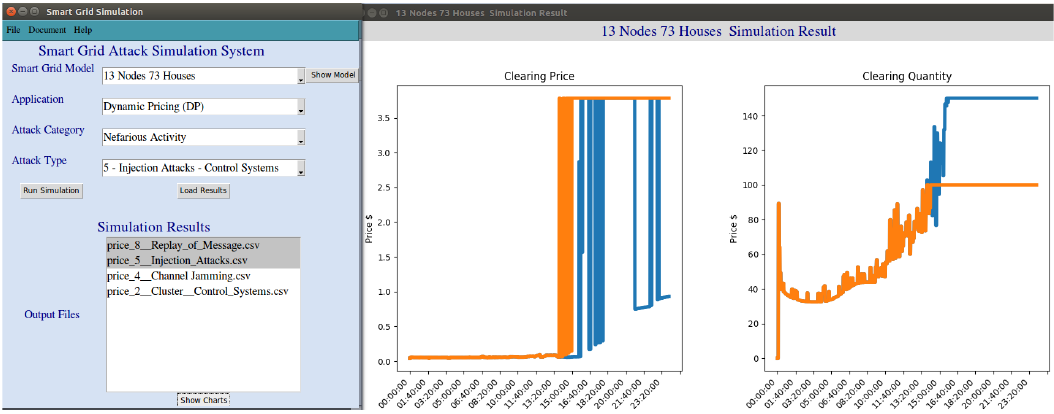
Figure 3. Smart grid attack co-simulation (GridAttackSim) desktop application (GUI).